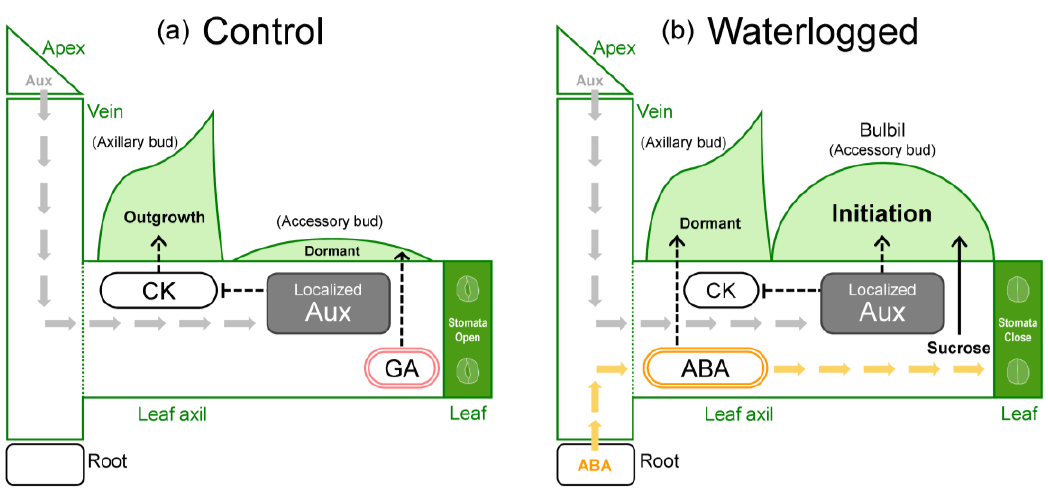
Figure 8. Schematic model of the physiological regulation of bulbil formation by plant hormones and sucrose under ( a ) control and ( b ) waterlogged soil conditions. CK, cytokinin; Aux, auxin; ABA, abscisic acid; GA, gibberellin.